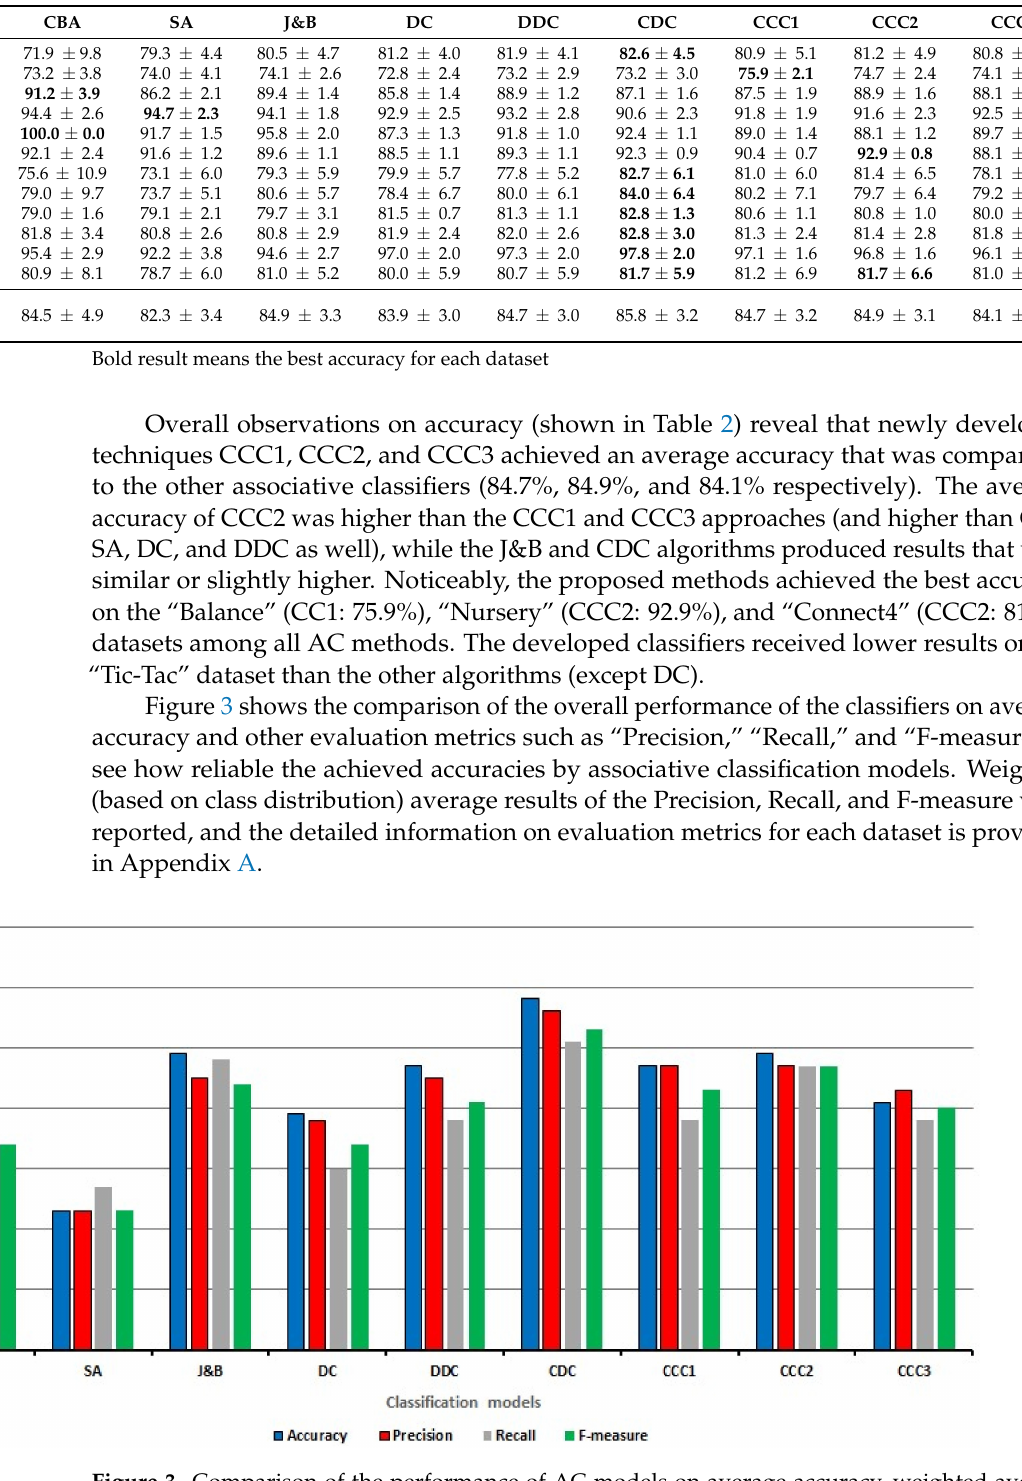
Figure 3. Comparison of the performance of AC models on average accuracy, weighted average Precision, Recall, and